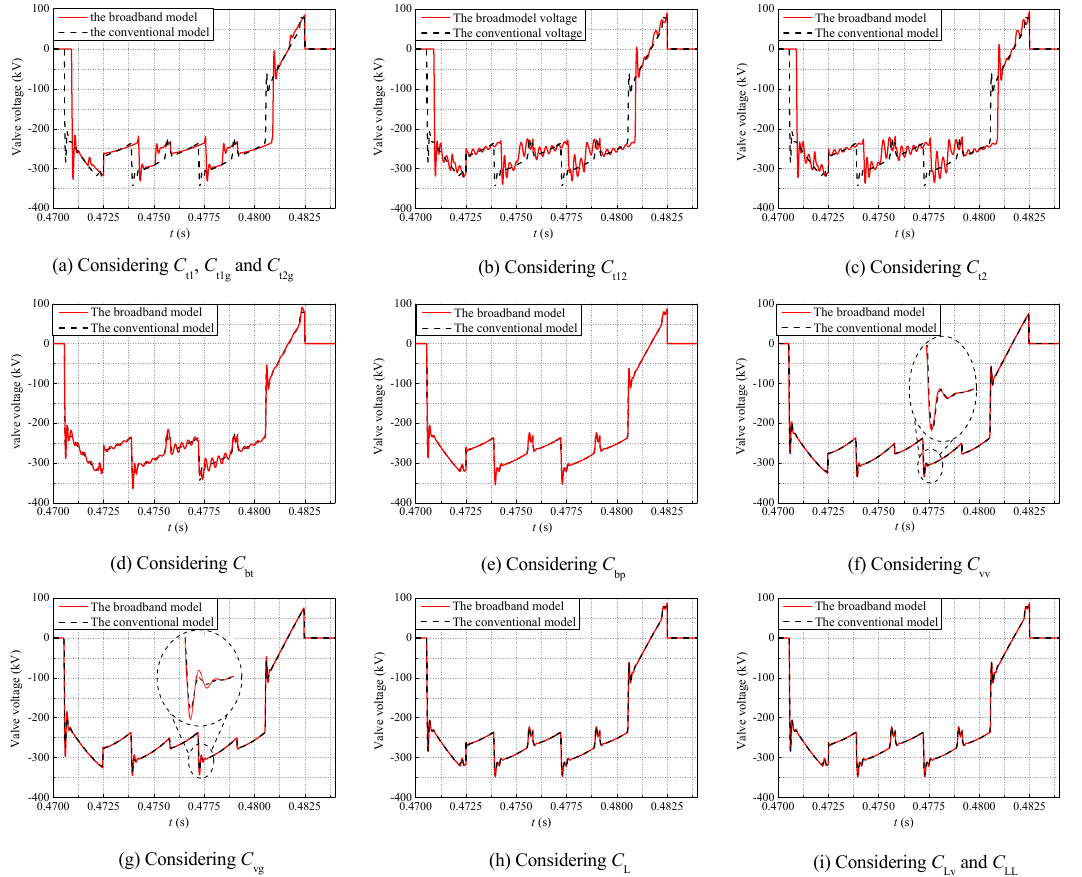
Figure 4. Comparisons of Transient Valve Voltages Obtained from Two Different Models.